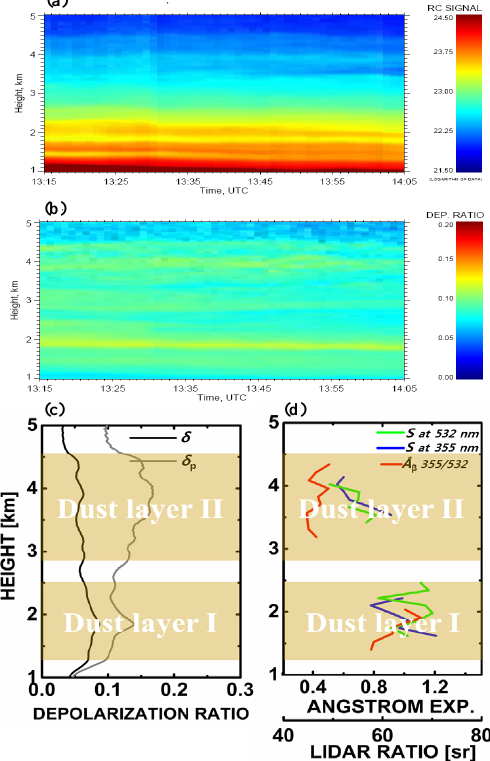
Figure 2. Measurement on 22 April 2012, 13:15–14:05UTC. Shown are (a) the time–height cross section of the range-corrected signal and (b) the volume depolarization ratio at 532nm. Also shown are the profiles of (c) the volume depolarization ratio and the linear particle depolarization ratio at 532nm, and (d) the lidar ratio at 355 and 532nm and the backscatter-related Ångström